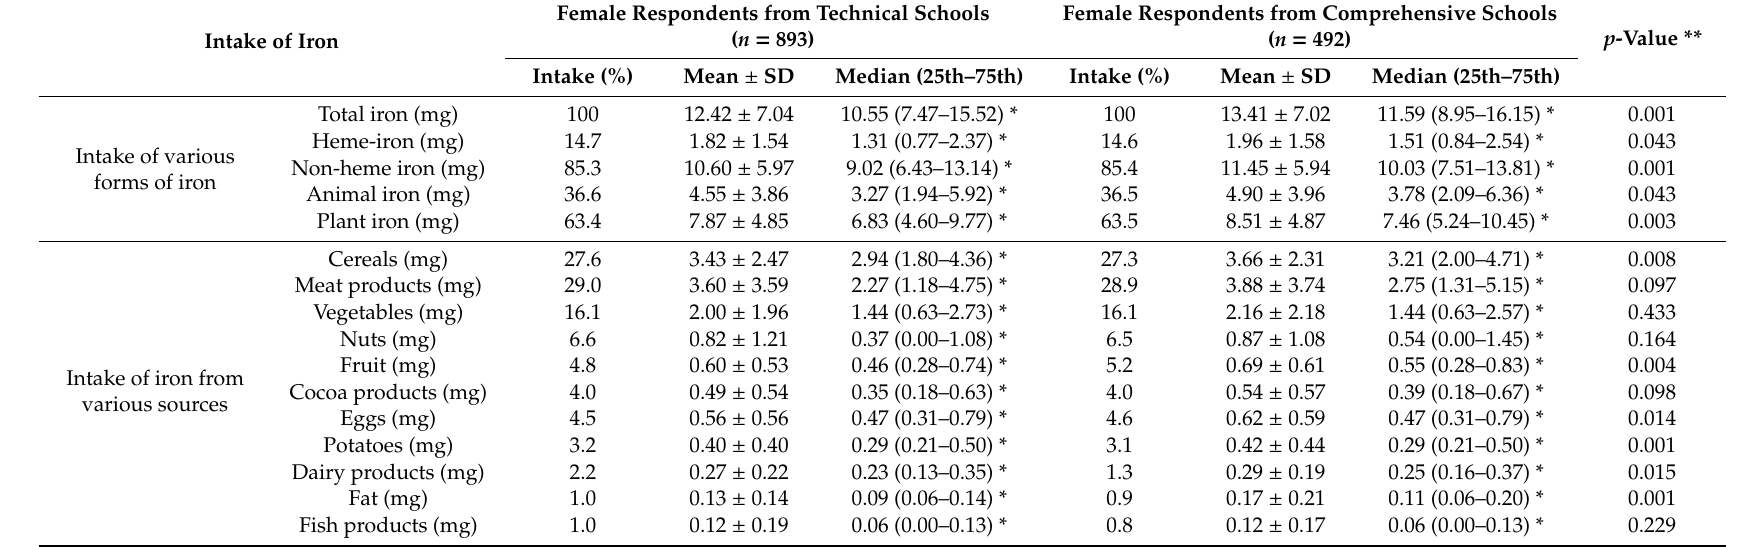
Table 8. Comparison of the intake of various forms of iron along with that of iron intake from various sources in the national sample of Polish female adolescents, in the sub-groups of female respondents from comprehensive and technical